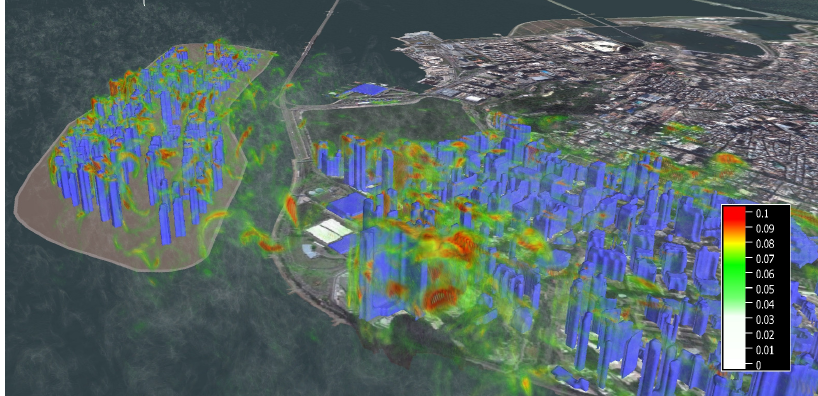
Figure 5. Snapshot of the absolute value of the 3-D rotation vector of the velocity field (red to white colors) for a simulation of the city of Macau, including a newly built-up artificial island (left). Buildings are displayed in blue. A neutrally stratified flow was simulated with the mean flow direction from the upper left to the bottom right, i.e., coming from the open sea and flowing from the artificial island to the city of Macau. The figure shows only a subregion of the simulation domain that spanned a horizontal model domain of about 6 . 1 × 2 . 0 × 1km 3 , and with an equidistant grid spacing of 8m. The copyright for the underlying satellite image is held by Cnes/Spot Image, Digitalglobe. For more details, see the associated animation (Knoop et al.,